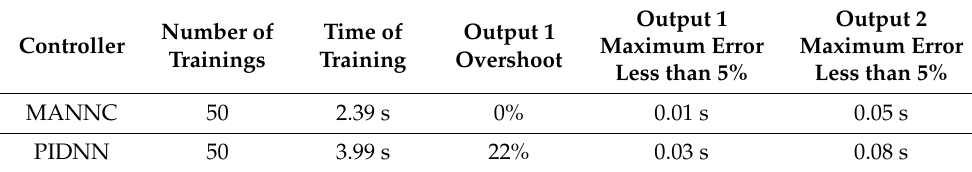
Figure 4. Case 2: accumulated error vs repeating number for MANNC. Table 7. Case 2: MANNC vs. PIDNN.